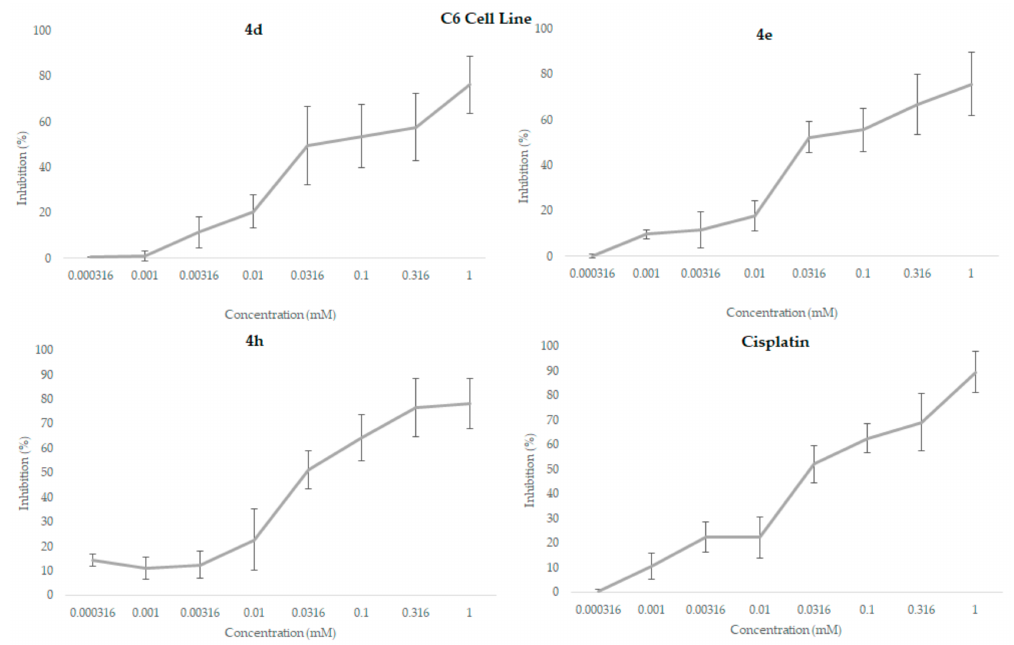
Figure 1. Inhibition values (%) of the compounds 4d , 4e , and 4h and cisplatin for each concentration against C6 cell line following a 24 h incubation period in MTT assay. All data were expressed as mean ± standard deviation.